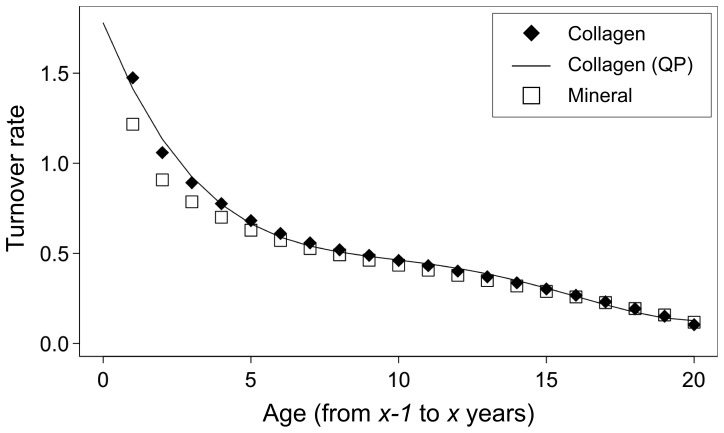
Estimated temporal changes in bone mineral and collagen turnover rates.Turnover rates of bone minerals and collagen are represented as discrete values, and that of collagen is fitted to QP plotted against age.